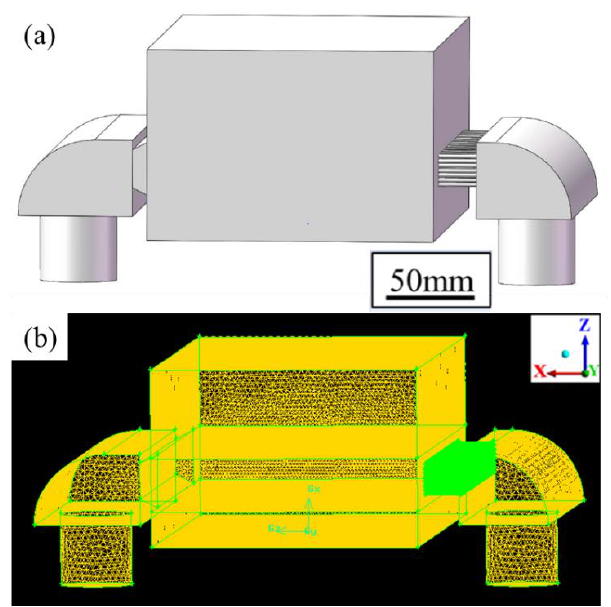
Figure 2. Numerical model of the LPBF processing chamber with a gas circulation system, ( a ) geo- metrical model; ( b ) after meshing.